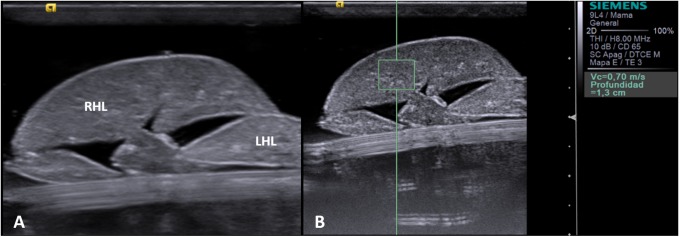
A, Ex vivo ultrasound image of the liver explant. RHL: right hepatic lobe; LHL: left hepatic lobe. B, Ex vivo assessment using ARFI.